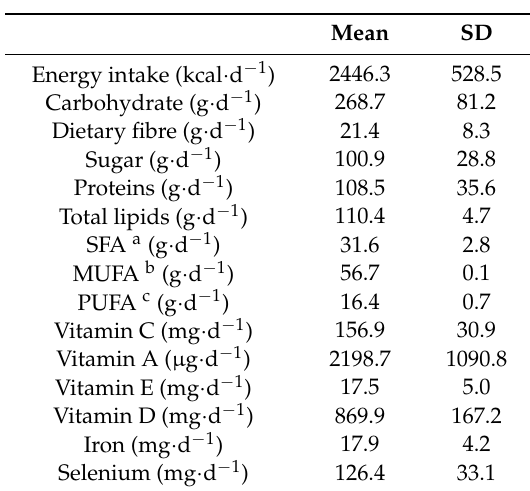
Table 3. Dietary parameters and caloric intake of the triathletes during the